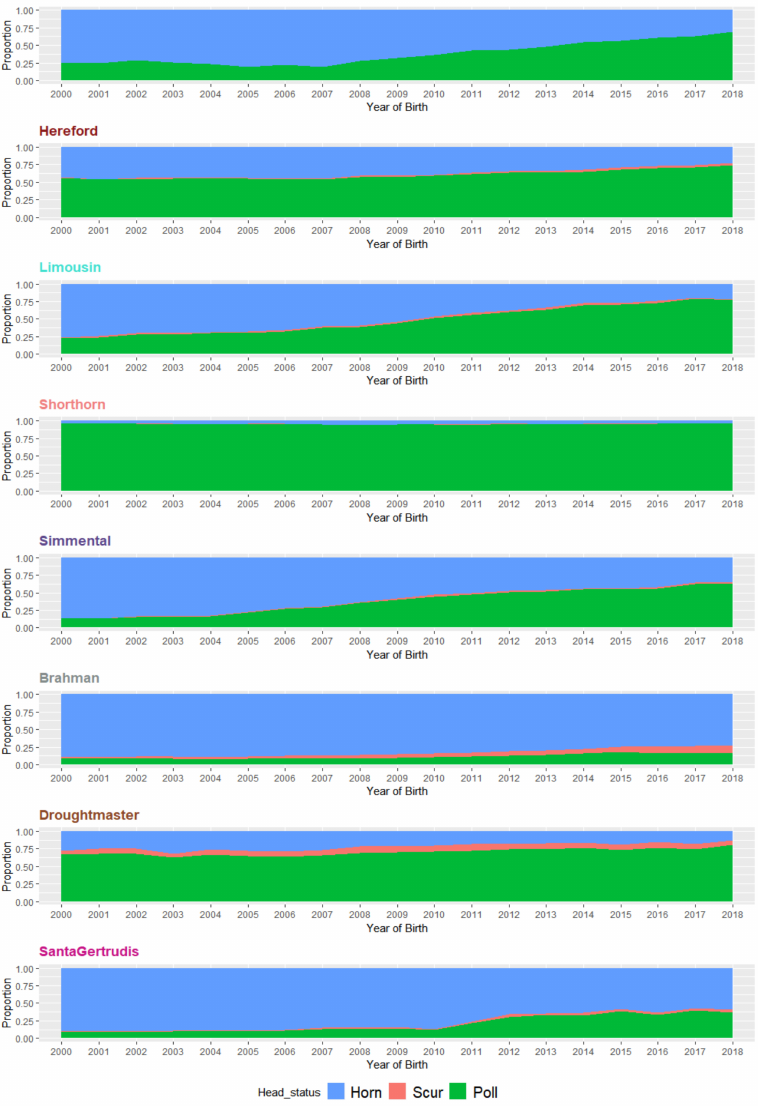
Figure 1. Breed-wise population trends of horn, scur, and poll animals from 2000 to